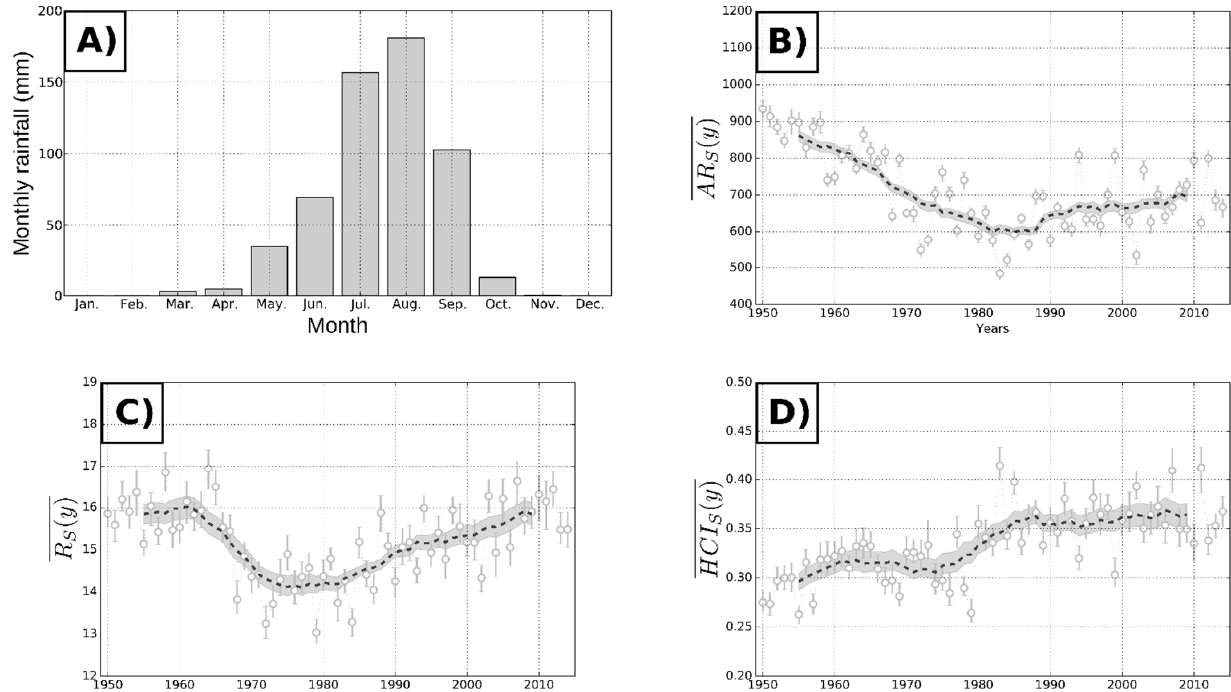
Figure 2. Evolution of rainfalls in the Sahel since 1950s, as registered in Niamey station. ( A ) Monthly rainfall at the Niamey (Niger) station with a seasonal effect. ( B ) Annual rainfall amounts in millimeters. ( C ) Mean intensity of wet days (average millimeters of water fallen during the rainy days), showing an increase since 2000. ( D ) Hydro-climatic intensity index, which measures the frequency of intense events, showing a progressive increase since 1990.